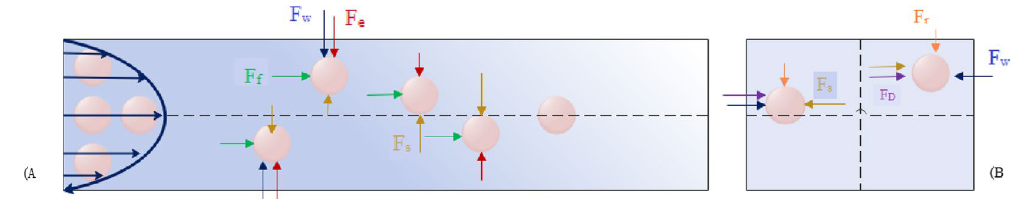
Figure 1. Dominant forces applied to particles within the microchannel at different transverse and longitudinal positions. ( A ) Microchannel length: The green arrows indicate the fluid drag force (F f ), which moves the particles along the microchannel. The blue arrows indicate the wall induced lift force (F w ), which pushes the particles toward the center of the microchannel. The brown arrows indicate the shear gradient lift force (F s ) that pushes the particles toward the microchannel wall. ( B ) Microchannel cross section: The orange arrows indicate the rotating lift force (F r ), which collects particles in the middle of the channel walls. Purple arrows indicate the Dean drag force (F D ) that pushes particles from the inner wall to the outer wall. Finally, the red arrows indicate the elasto-inertial lift force (F e ) that pushes the particles toward the channel’s